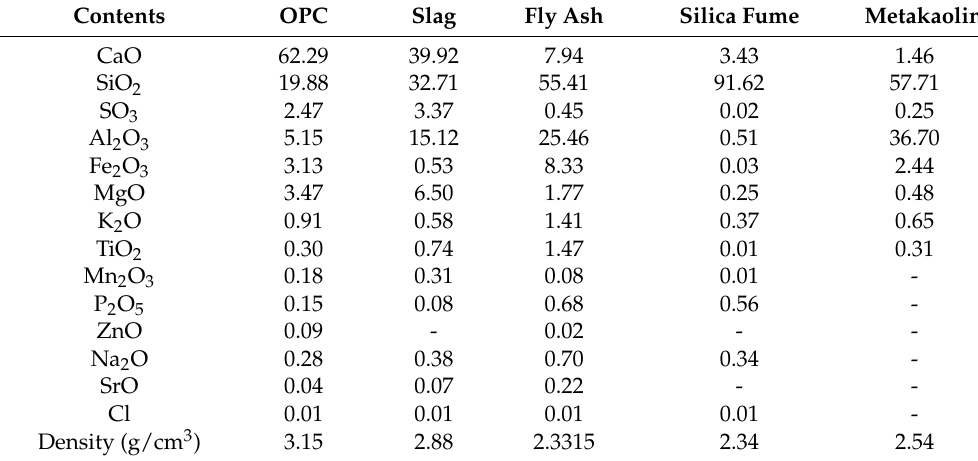
Table 1. Chemical compositions (mass %) and densities (g/cm 3 ) of OPC and supplementary cementitious